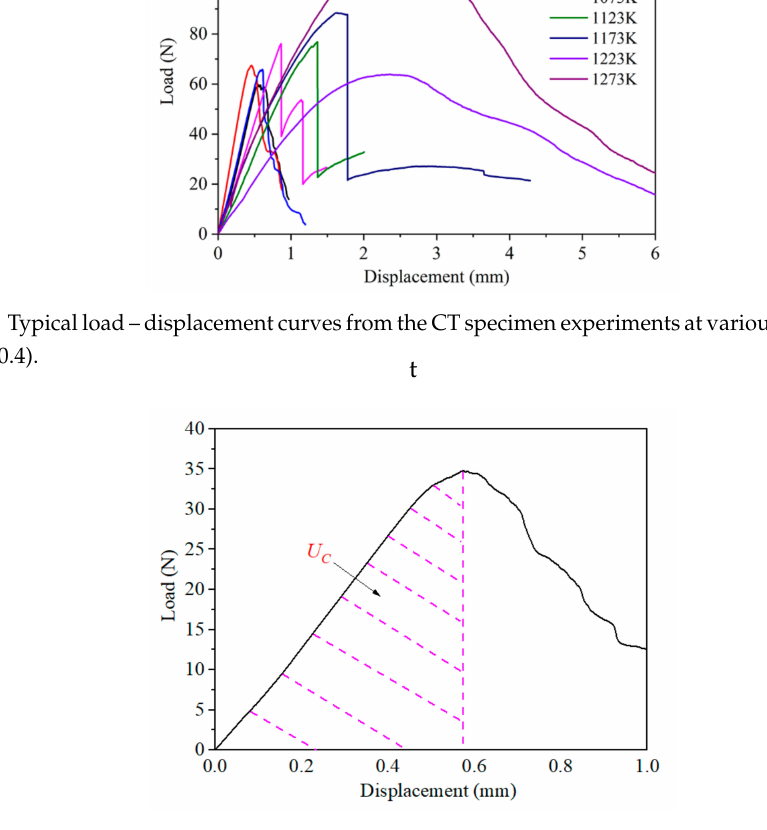
Figure 4. The area under one load – displacement curve of a CT specimen at the maximum